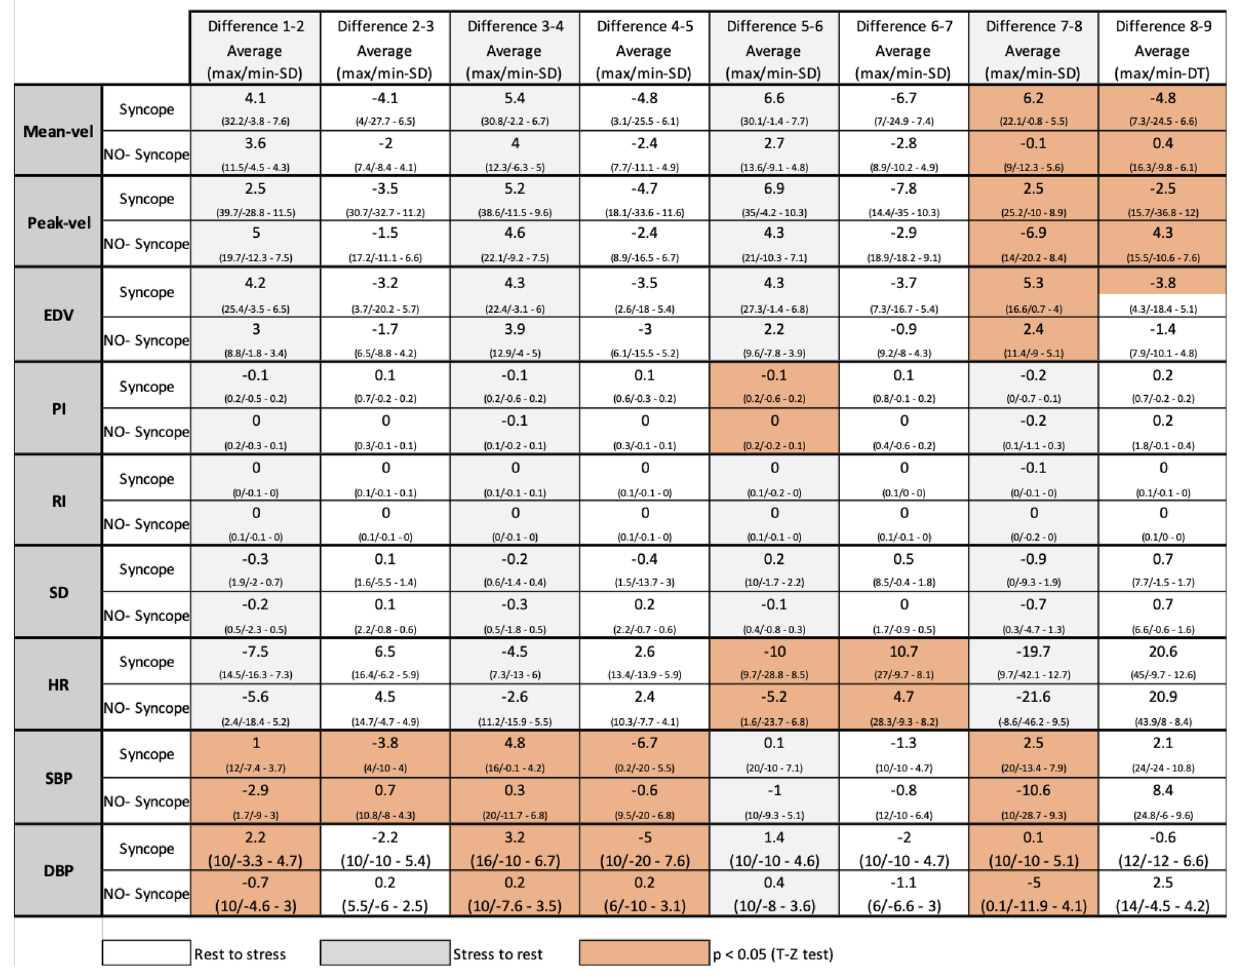
Table 2. Relationship of the differences of the mean of each variable with consecutive change of stage. SBP systolic blood pressure, DBP diastolic blood pressure, MBP mean blood pressure, Peak-vel . systolic velocity of the MCA, Mean-vel . mean velocity of MCA, EDV end diastolic velocity of the MCA, PI pulsatility index, RI resistance index, SD systolic/diastolic velocity